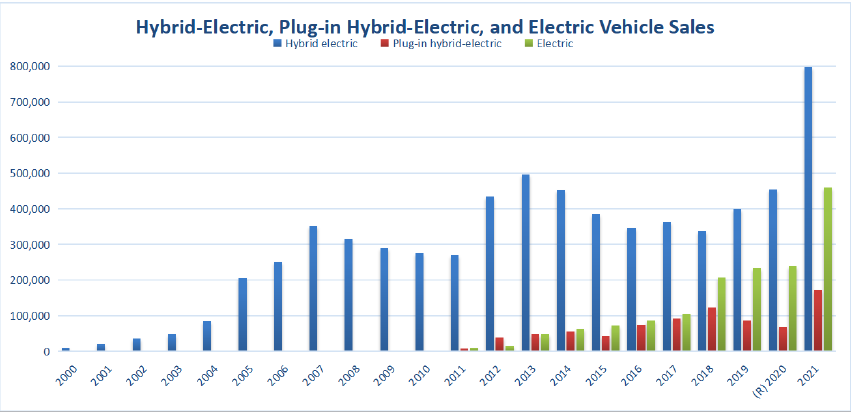
Figure 1. Sales illustration of HEV/PHEV/PEV on the US market [1].